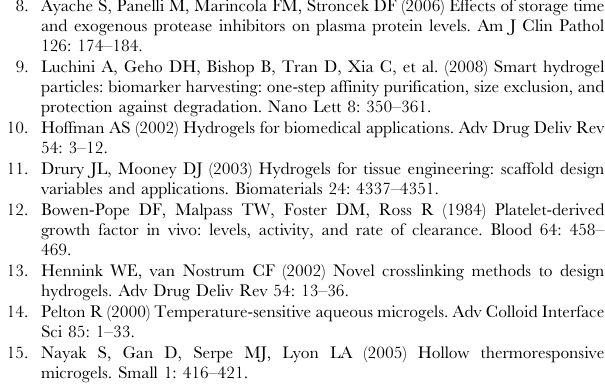
Table S1 Concentration of PDGF spiked in human serum by core-shell particles. Mass spectrometry analysis of proteins eluted from core shell particles incubated with human serum containing PDGF spiked at a concentration of 5